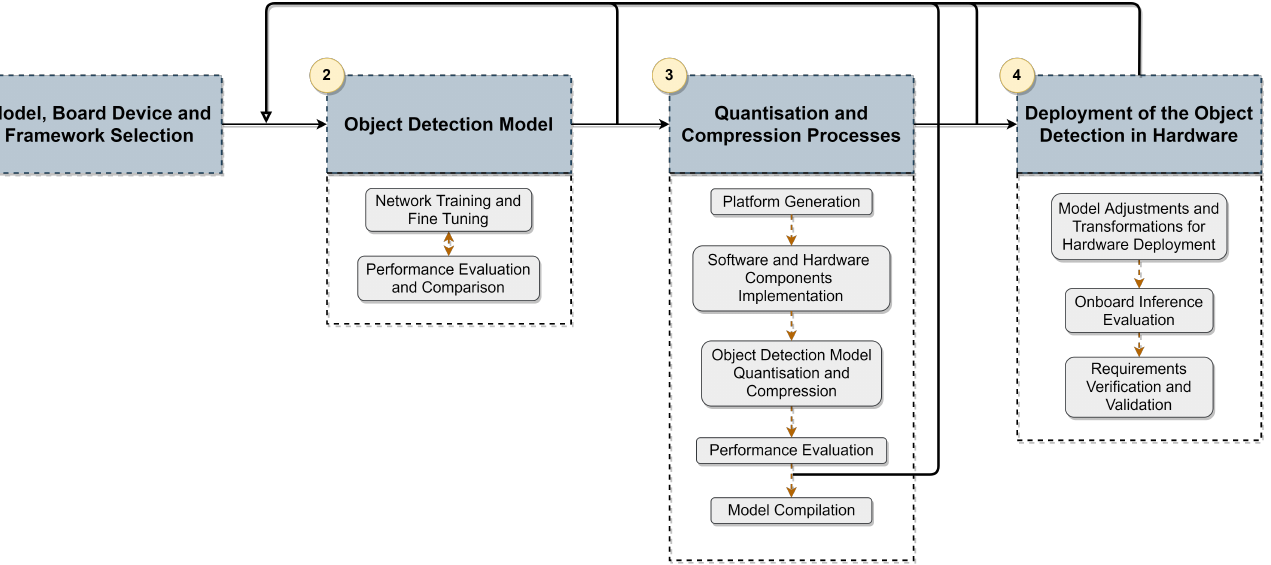
Figure 2. Methodology used for the deployment of the object detection model in the hardware